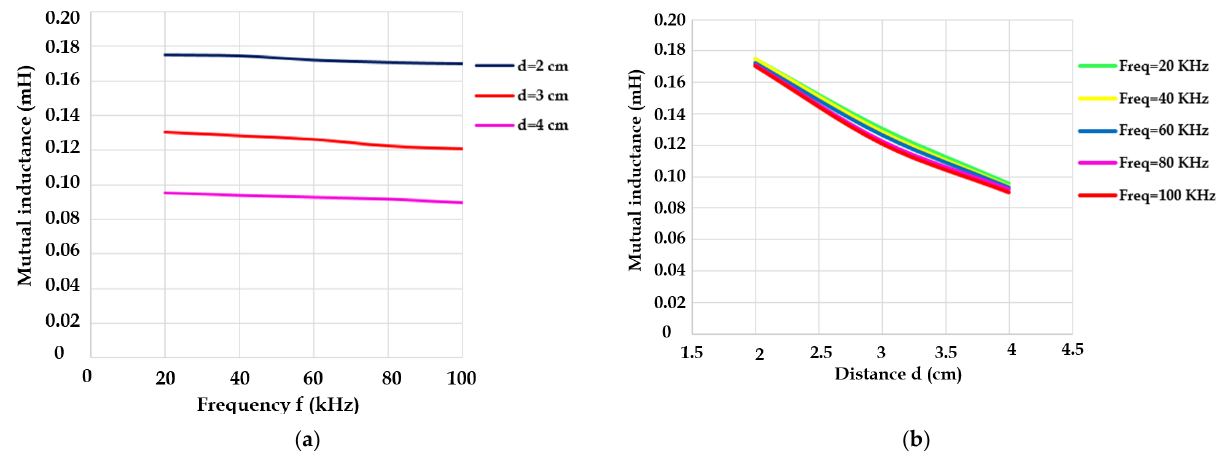
Figure 12. Mutual inductance variation as function of ( a ) frequency and ( b ) distance.